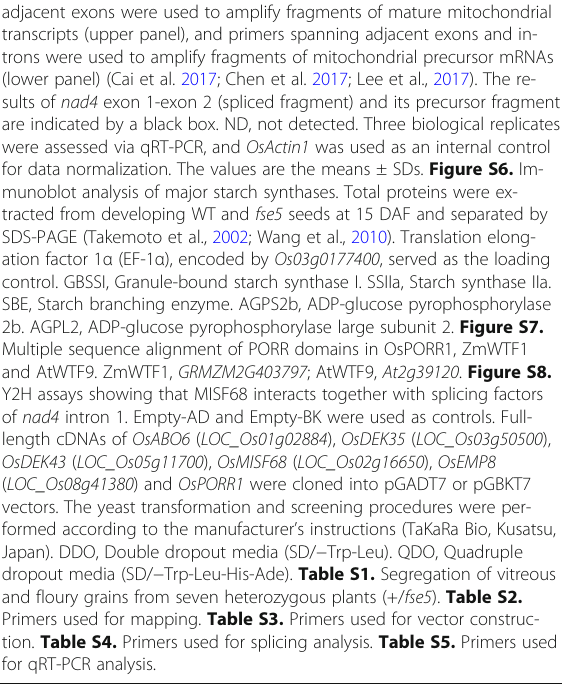
Additional file 1: Figure S1. Homozygous fse5 seeds were produced by a heterozygous plant (+/ fse5 ). Segregation of grains with normal vitreous and floury (black, red arrows) kernels occurred among all seeds harvested from a single heterozygous plant (+/ fse5 ) and was viewed by an X-ray viewer (PD-HA). Bar, 1 cm. Figure S2. Phenotypes of seeds and seedlings of the WT and fse5 mutant lines. A-D, 1000-grain weight (A), and length (B), width (C) and thickness (D) of mature WT and fse5 seeds. E-H, Total starch (E), amylose (F), protein (G) and lipid (H) contents of ma- ture WT and fse5 seeds. I, Germination percentages for WT and fse5 seeds at 7 DAS in culture dishes. J, Percentages of seedlings grown from WT and fse5 seeds at 9 DAS in soil. K, Heights of 9-day-old seedlings grown from WT and fse5 seeds. The values are the means ± SDs. **, P < 0.01, Stu- dent ’ s t test. Figure S3. OsPORR1 KO lines generated via CRISPR/Cas9. A, KO target site in the genomic sequence of OsPORR1 . B, Target sequences of the OsPORR1 allele in four independent positive lines of Nipponbare. Single-nucleotide insertions (red letters, A, T and G) occurred in KO-140, KO-155 and KO-172, and a 32-nucleotide deletion (red dotted line) was present in KO-174. The black box indicates the protospacer-adjacent motif (PAM) sequence. C, Phenotypes (upper panel) and transverse sec- tions (lower panel) of seeds from Nipponbare and KO lines. Bars, 1mm. Figure S4. GUS staining of various tissues from a ProOsPORR1:GUS trans- genic plant. Left-to-right, young seedling, root, stem, leaf, leaf sheath, panicle and developing seed. The promoter of OsPORR1 was inserted into a pCAMBIA1381Z vector, which was then introduced into Nipponbare via Agrobacterium tumefaciens transformation. GUS staining was performed as described previously (Zhang and Muench, 2015). Bars, 2 mm. Figure